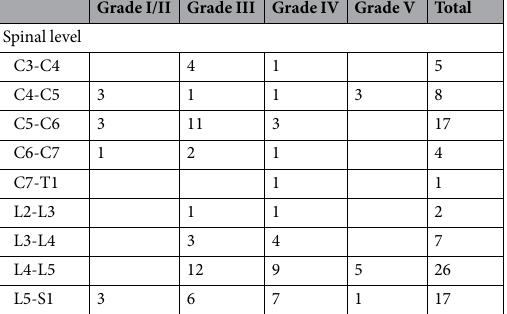
Table 1. Clinical characteristics of the study